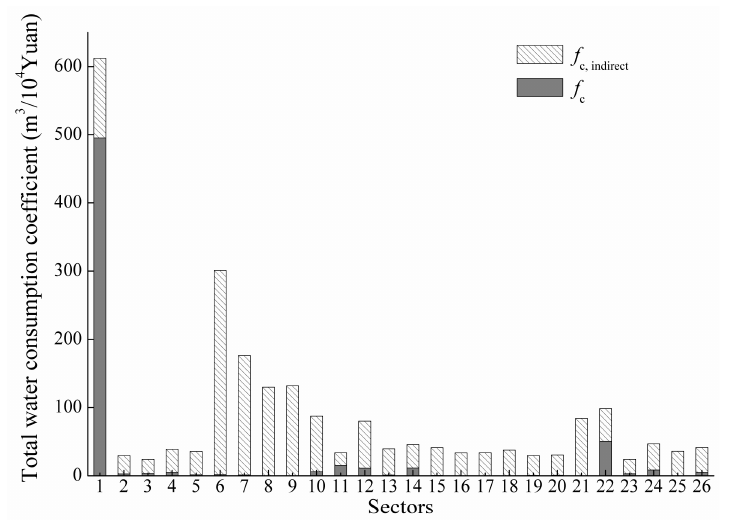
Figure 5. Total water consumption coefficients of different sectors in